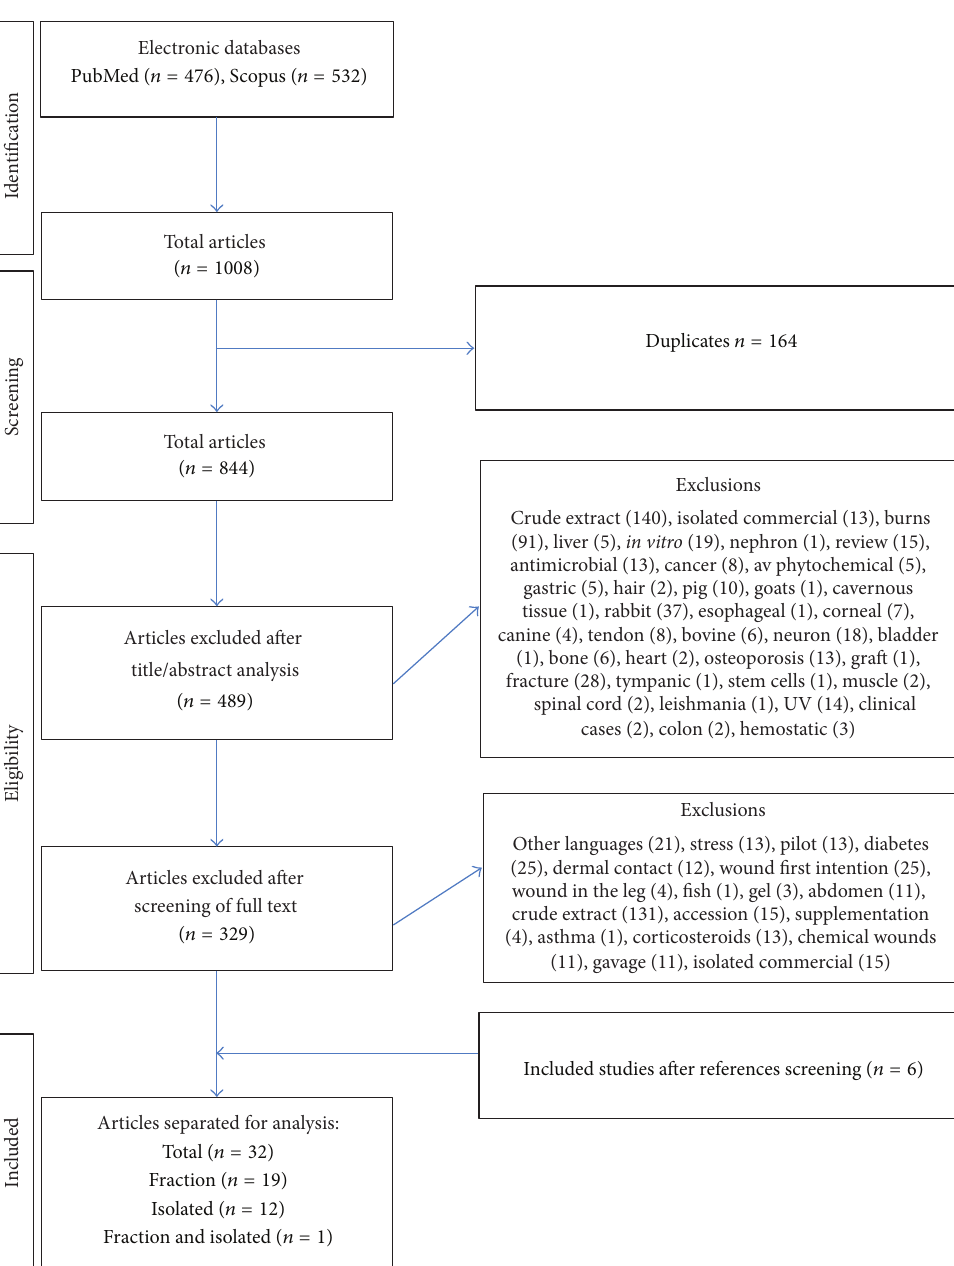
Figure 1: Flowchart of the strategy applied to recover preclinical studies according to the PRISMA